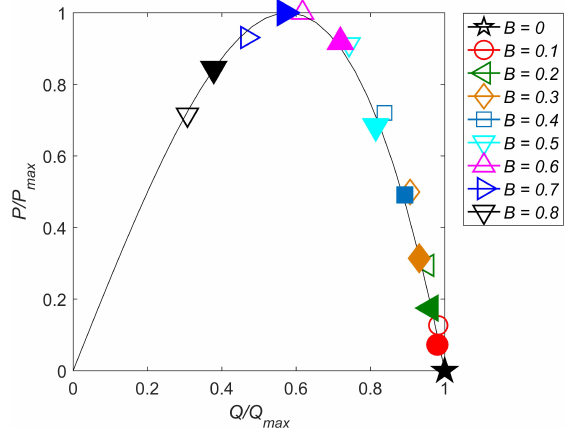
Figure 5. Normalised maximum power removed by the turbines against the normalised maximum flow rate for increasing values of B . TVD (unfilled markers), ADI (filled markers), and the analytical solution (continuous line). Reproduced from [55] with permission from